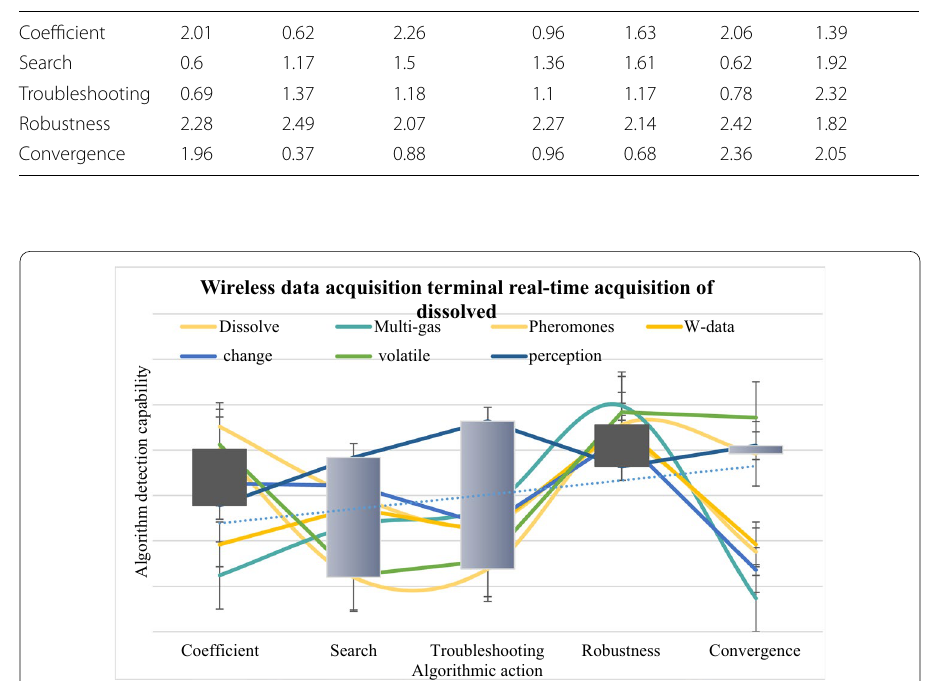
Fig. 7 Wireless data acquisition terminal real-time acquisition of dissolved